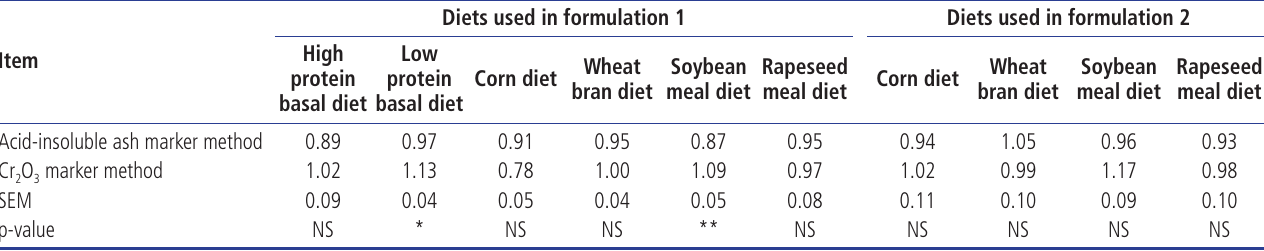
Diets used in formulation